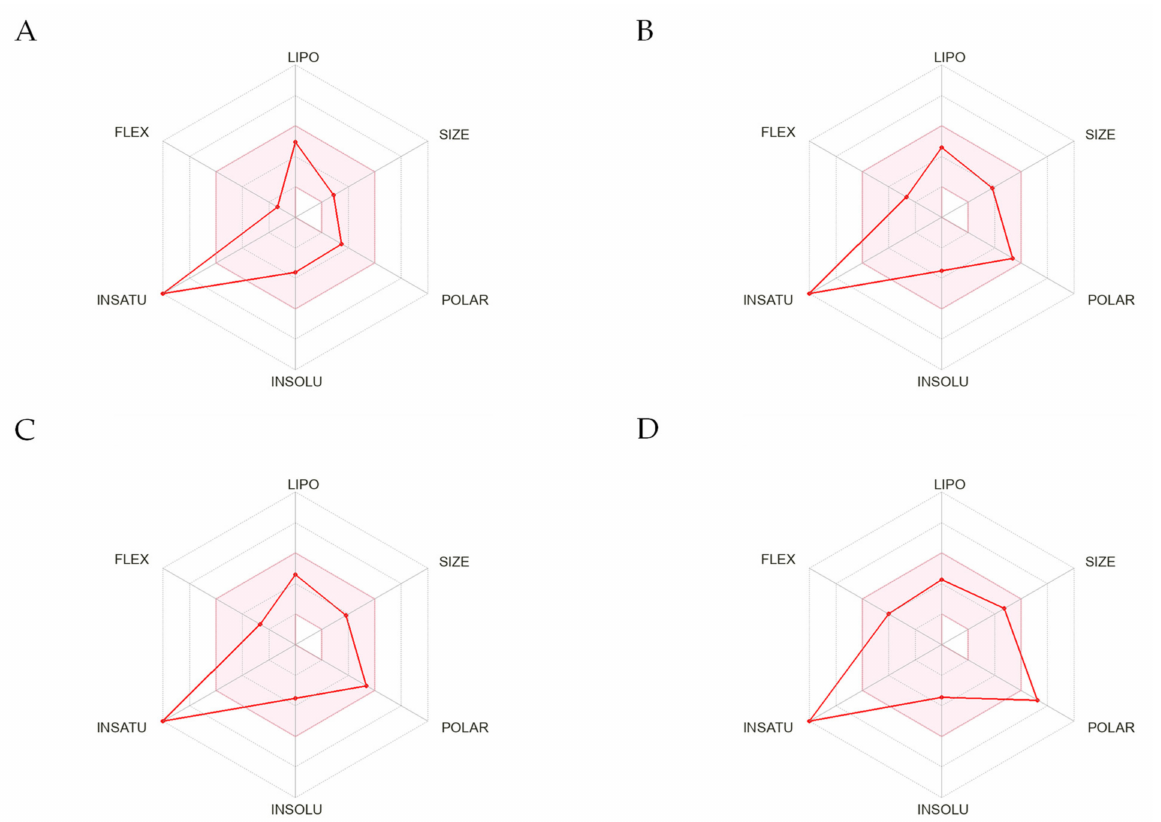
Figure 7. The Bioavailability Radar [111] for resveratrol ( A ), resveratrol-4 (cid:48) - O -sulfate ( B ), resveratrol- 3- O -sulfate ( C ), resveratrol-3- O -4 (cid:48) - O -sulfate ( D ). The pink area represents the optimal range of pa- rameters determining oral bioavailability. The pink has the following properties: LIPO—lipophilicity (XLOGP3 between − 0.7 and +5.0), SIZE—molecular weight (MW between 150 and 500g/mol), POLAR—polarity (TPSA between 20 and 130Å 2 ), INSOLU—solubility (log S not higher than 6), INSATU—saturation (fraction of carbons in the sp 3 hybridisation not less than 0.25) [129] and FLEX - flexibility (no more than nine rotatable